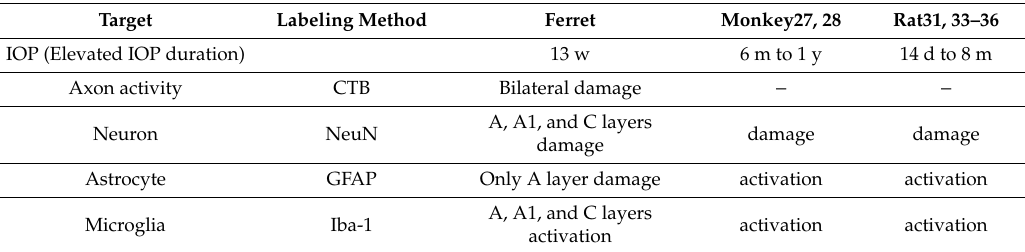
A, A1, and C layers damage A, A1, and C layers Iba-1 activation